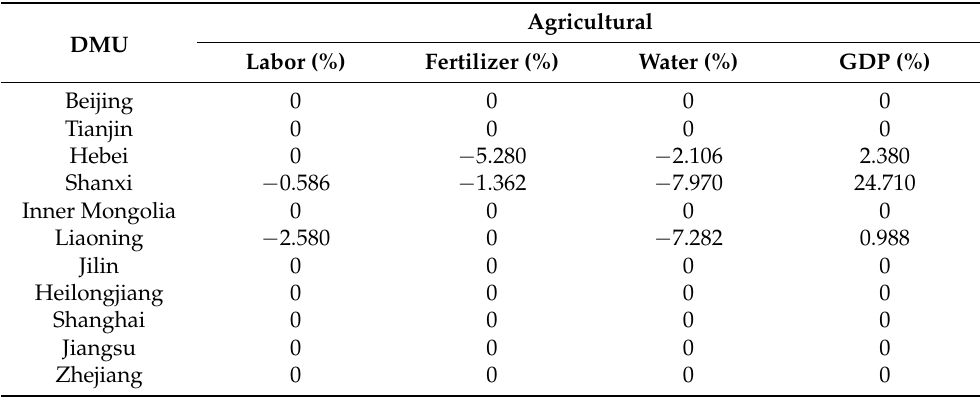
Table A2. Average adjustment range of input and output